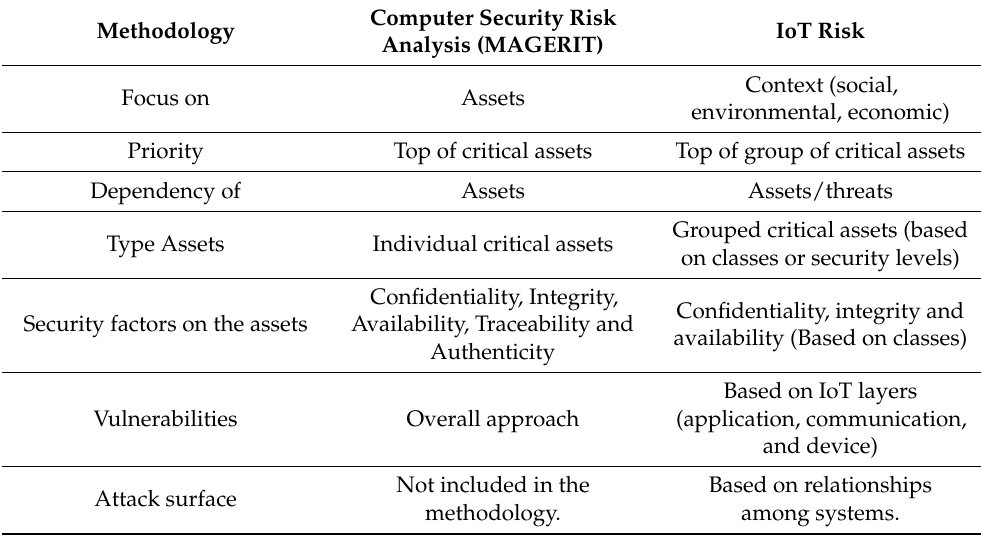
Table 12. Comparison of traditional methodologies versus the proposal of IoT security risk in the present